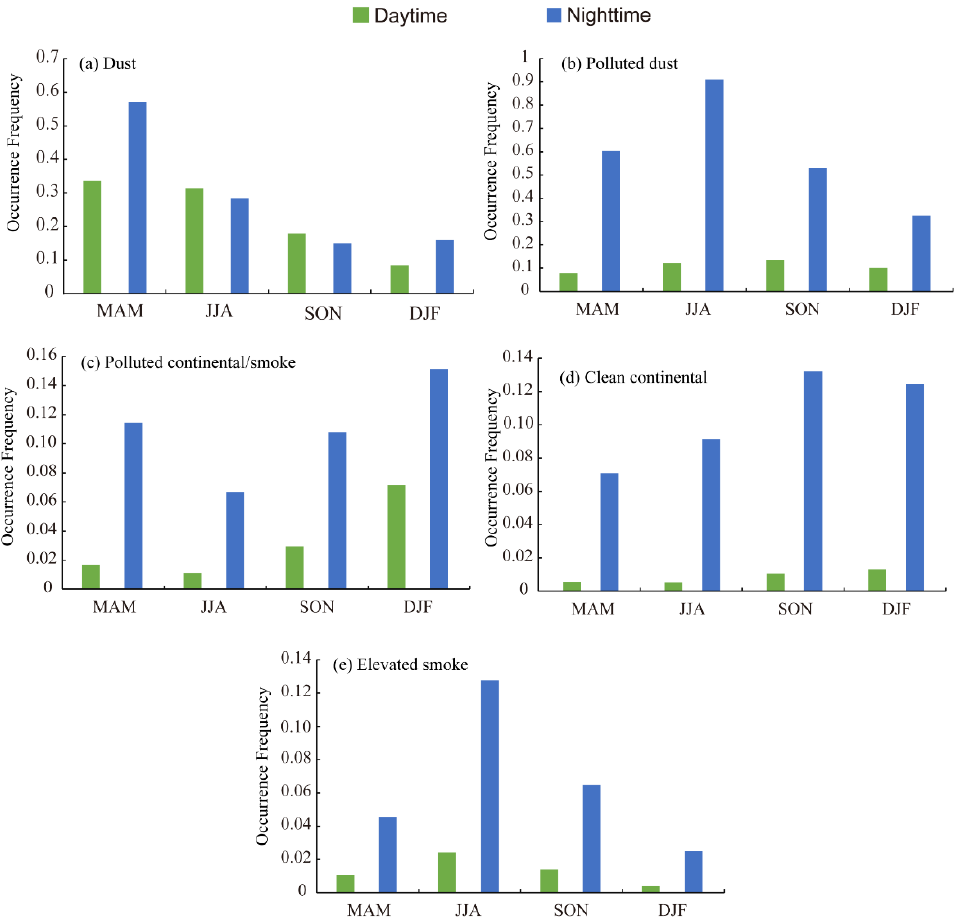
Figure 3. Seasonal and diurnal variations in occurrence frequency of aerosol subtypes in the daytime and nighttime from 2007 to 2021: ( a ) dust; ( b ) polluted dust; ( c ) clean continental; ( d ) polluted con- tinental/smoke; ( e ) elevated